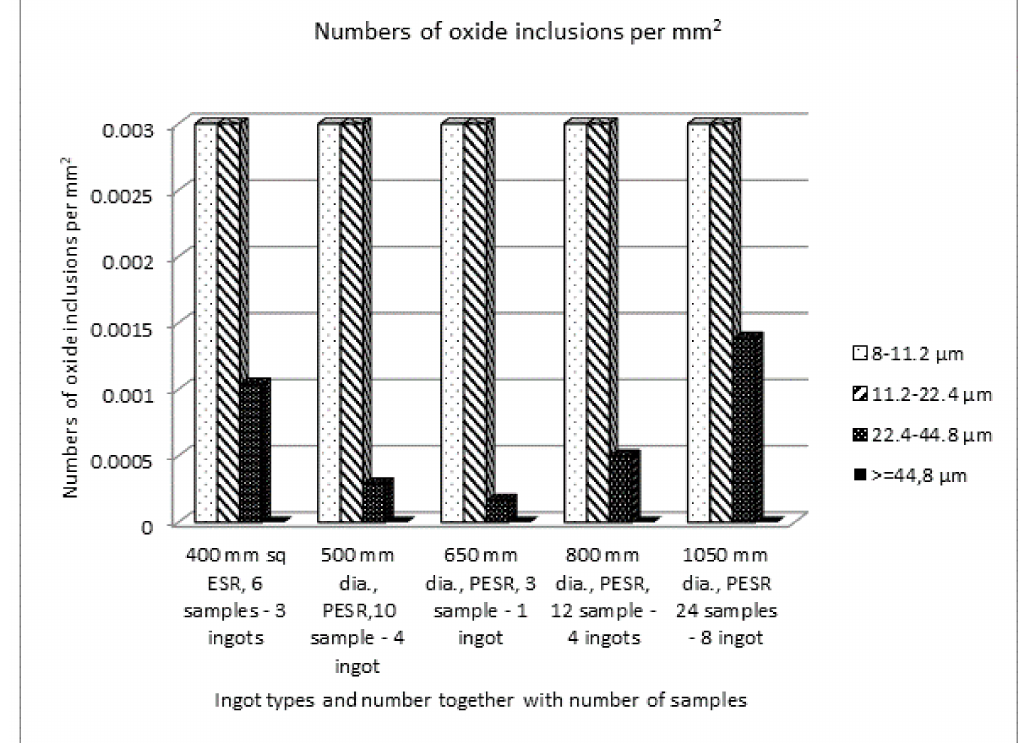
Figure 15. Number of oxide inclusions per mm 2 , for different ingot sizes from rolled/forged and heat-treated material. No inclusions > 44.8 µ m were